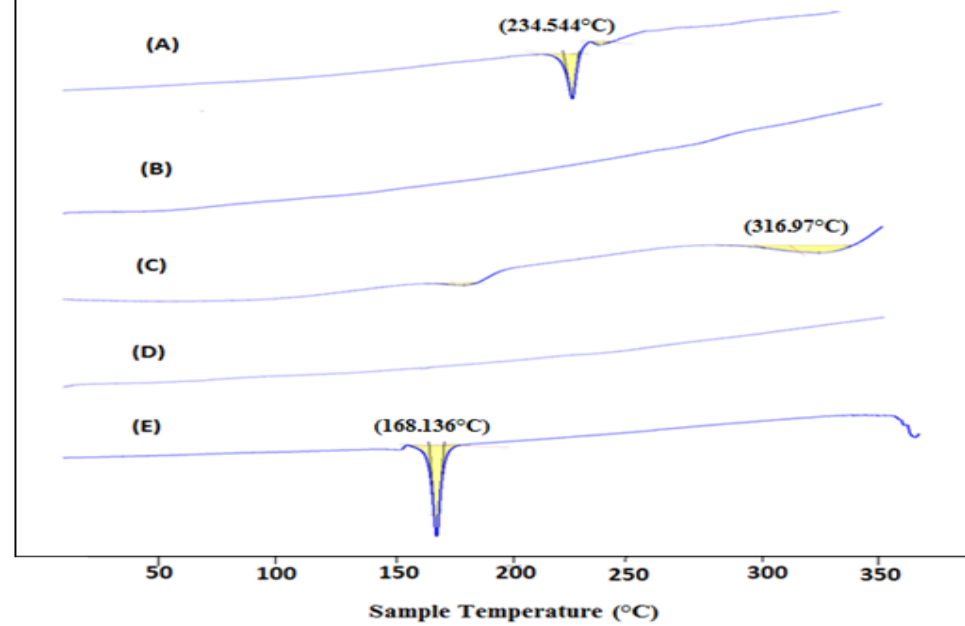
Figure 5. DSC thermogram of Erlo (A), cinnamon biopolymer (B), polyvinyl alcohol (C), Dox–Erlo NPs (D), and Dox–Erlo-NP conjugates (E).